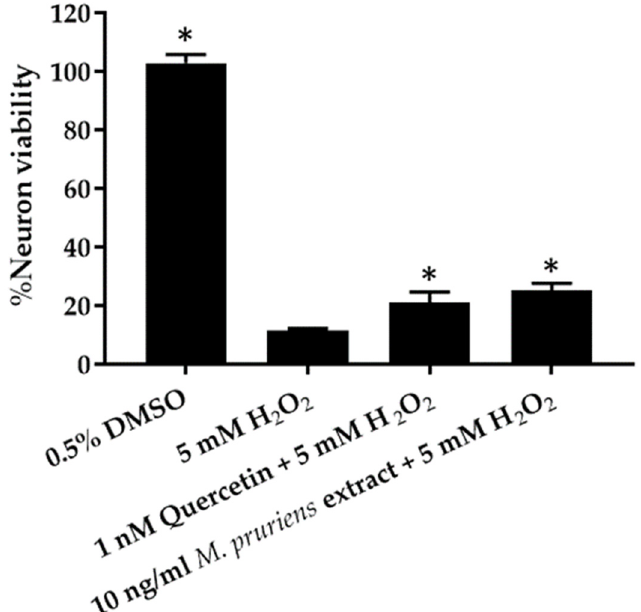
Figure 3. P19-derived neurons cell culture viability in 10 ng/mL M. pruriens seed aqueous extract co-treated with 5 mM hydrogen peroxide compared with the positive control (1 nM quercetin co-treated with 5 mM hydrogen peroxide) and toxic condition (5 mM hydrogen peroxide). * p < 0.05 compared with toxic condition (5 mM hydrogen peroxide).